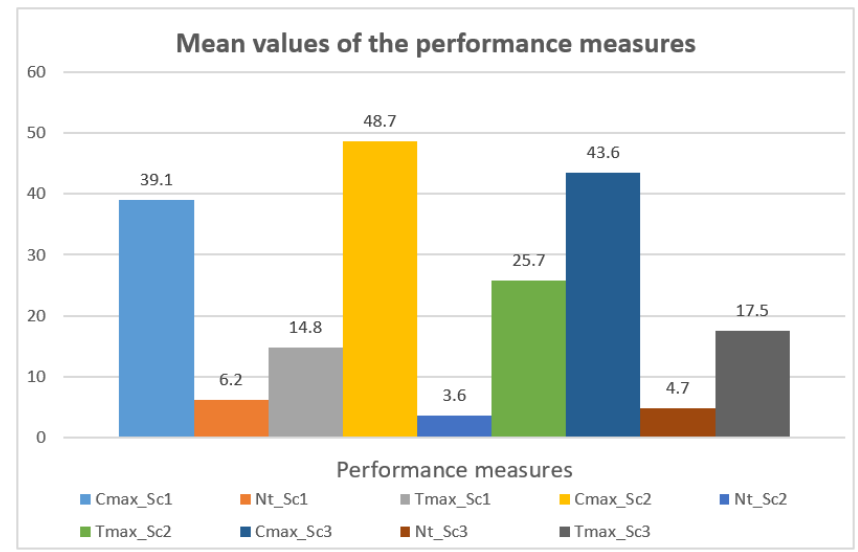
Figure 6. Mean performance measures’ values of the scheduling solutions from scenarios 1, 2 and 3.